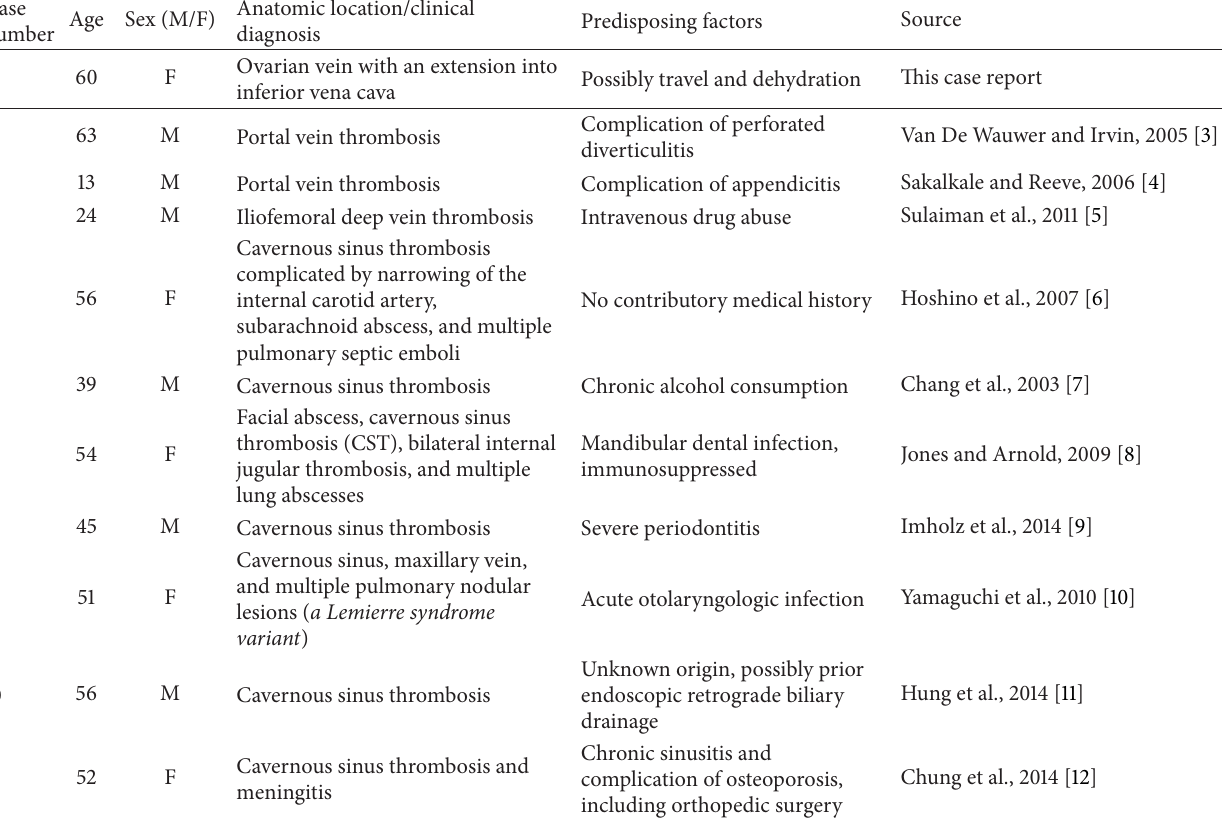
Table 1: Cases reported in the literature of septic thrombophlebitis with confirmed Streptococcus constellatus involvement. Case Anatomic location/clinical Age Sex (M/F) number